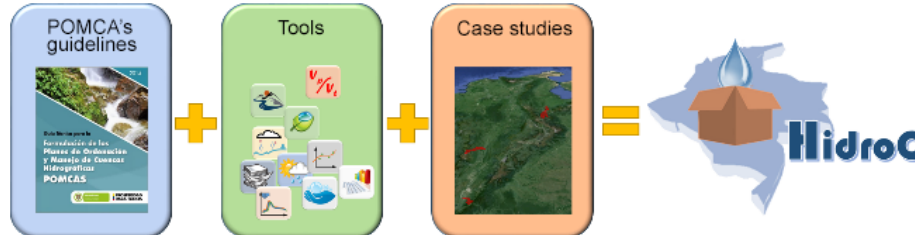
Figure 1. Main components of HidroCHEP’s architecture.